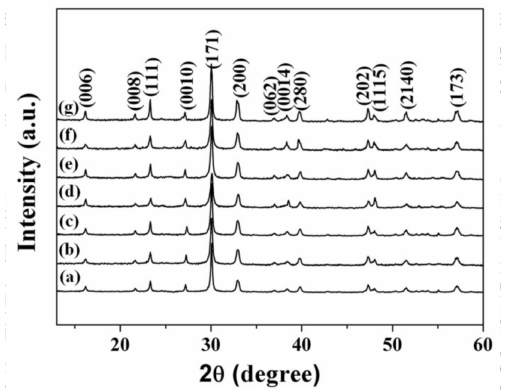
Figure 3. X-ray diffraction patterns of (a) the pristine Bi 4 Ti 3 O 12 ; (b) Bi 4 Ti 3 O 12 − x (350 ◦ C, 20 min);